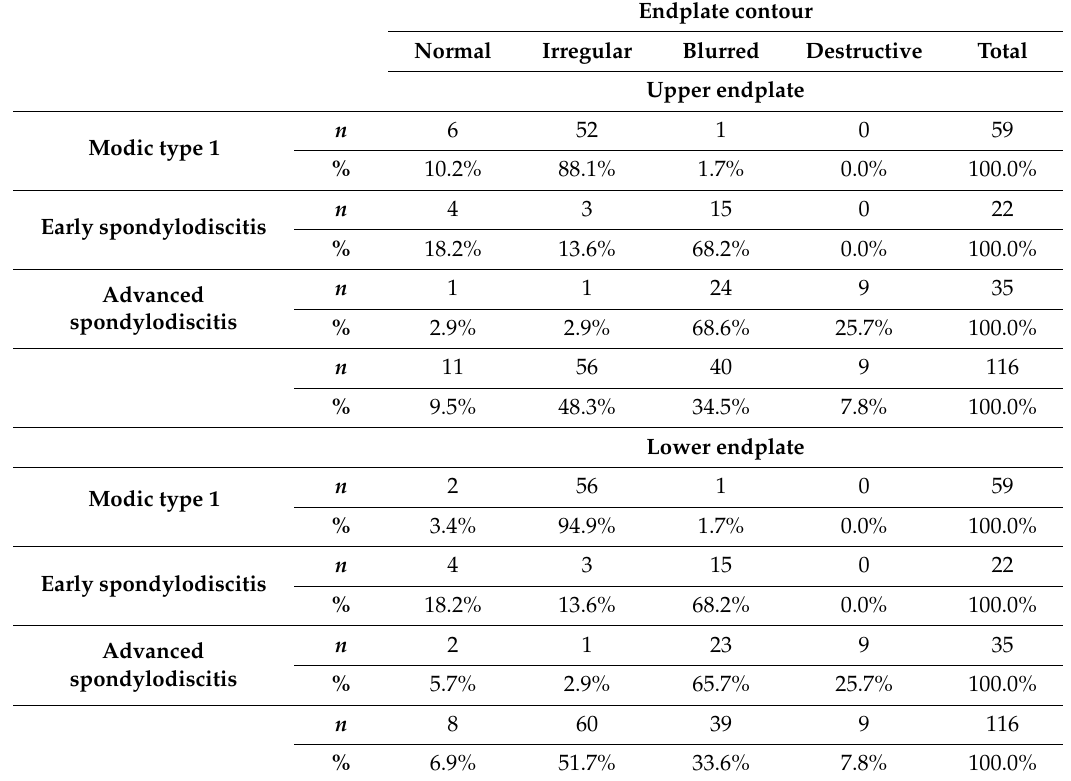
Table 3. Contour changes of the upper and lower vertebral endplates.